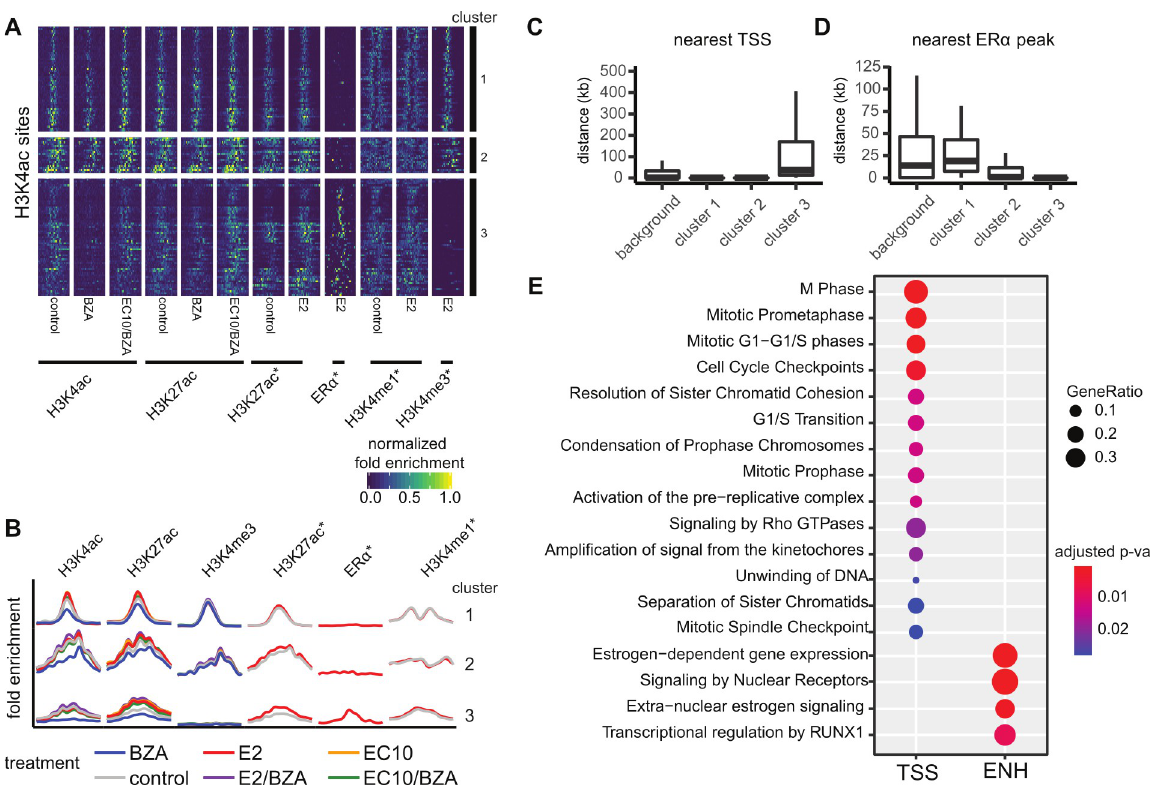
Fig 4. H3K4ac is regulated in response to bazedoxifene treatment in MCF7 cells. Clustering of 130 differentially enriched H3K4ac marked regions reveals two distinct epigenetic signatures. A) Heatmap of enrichment profiles across genomic regions within 4kb of H3K4ac sites clustered using k-means (k = 3). B) Aggregated mean profiles of clusters identified in A; the x-axis corresponds to the mean normalized fold- enrichment values. C) Distance by cluster from each site to the nearest transcript start site (TSS) of a protein-coding gene. D) Distance by cluster from each site to the nearest ER α peak. E) KEGG enrichment analysis of pathways associated with genes nearby cluster 1 and 2 promoter proximal regions (TSS) or cluster 3 enhancer (ENH)